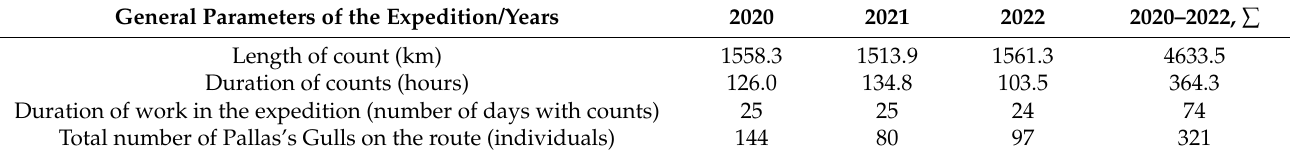
Table 3. Length, duration of surveys and expedition work, and the number of counted Pallas’s Gulls ( Ichthyaetus ichthyaetus